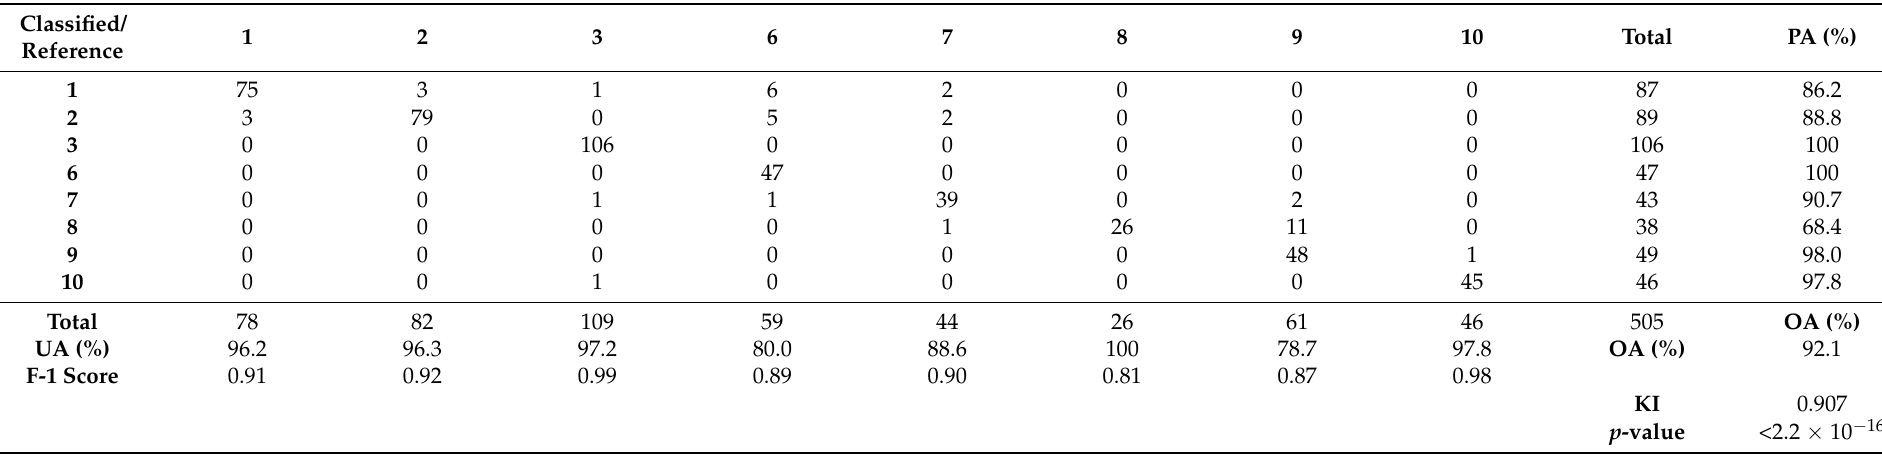
Table 6. The Confusion matrix obtained for the final classification of the TNH tile produced using the DivByAll aggregation method. Obtained metrics: Producer’s Accuracy (PA),